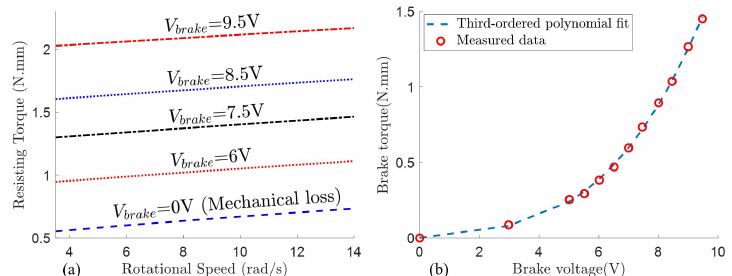
Figure 8. ( a ) An example of the system resisting torque measured at different brake voltage and ( b ) the measured HB-300 hysteresis brake torque curve as a function of the input voltage.